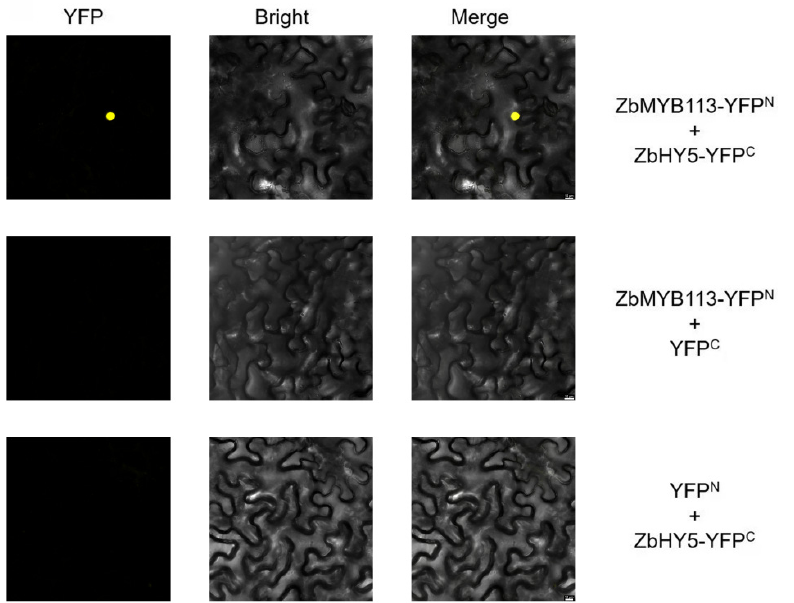
Figure 6. The BiFC assay was carried out to verify the interaction between ZbHY5 and ZbMYB113. Bars, 10 µm.